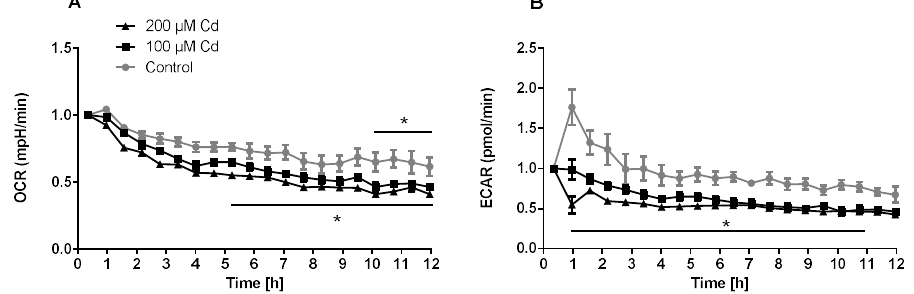
Figure 6. Extracellular flux measurements of oxygen (OCR) and protons (ECAR) of coelomocytes exposed in vitro to different concentrations of Cd. *Two-way ANOVA and Tukey’s multiple comparisons test indicates statistical significance at p ≤ 0.05.